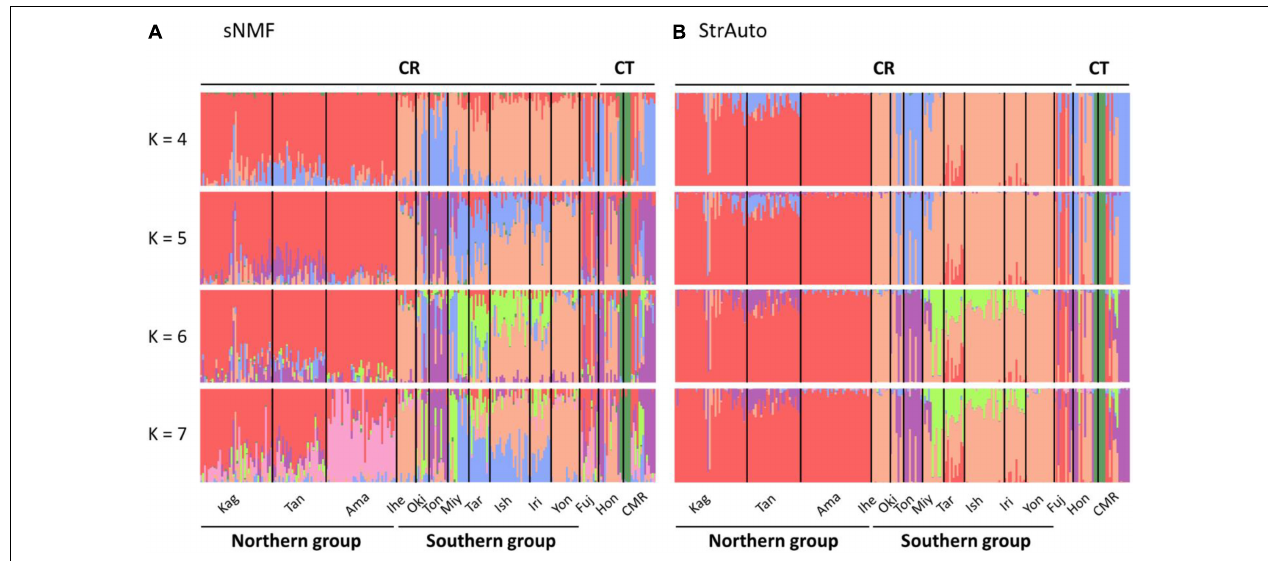
FIGURE 2 | Island population genetic structure inferred by (A) the sparse nonnegative matrix factorization (sNMF) algorithm and (B) the StrAuto software. CR and CT denote Cycas revoluta and Cycas taitungensis , respectively. The island names are abbreviated as the first three characters of the full names.